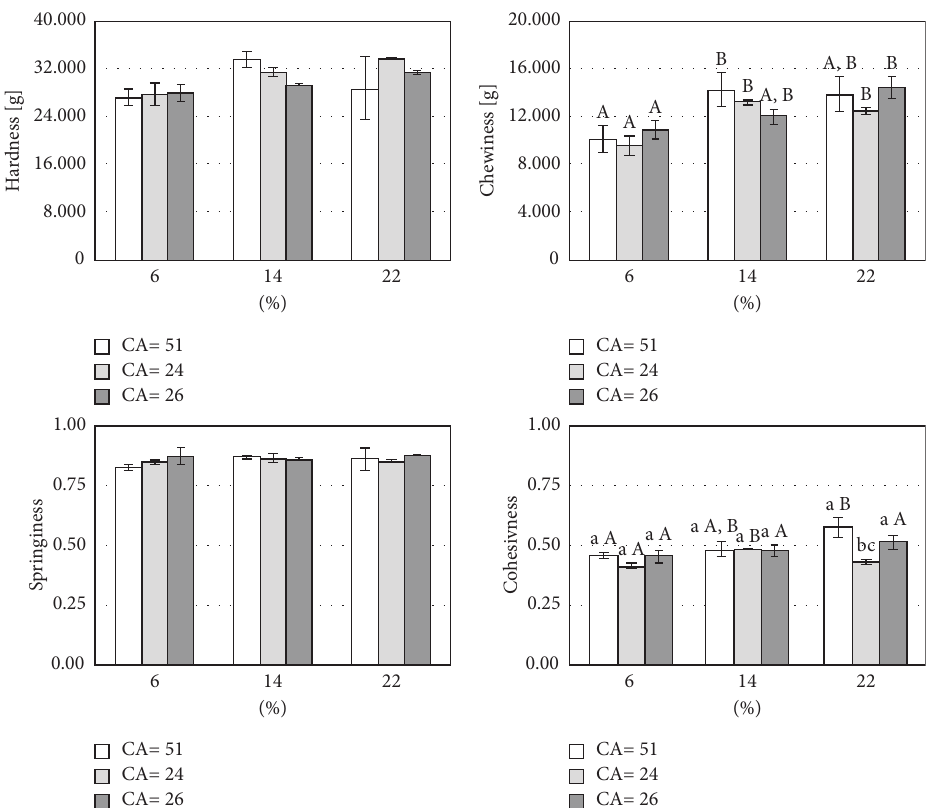
Figure 6: Texture profle analysis parameters for recipe R 1 ( X -axes: overstufng percentage). Means between each same split-plot pa- rameters combination ± standard error. Diferent lowercase letters indicate that the average values difer signifcantly ( P < 0 . 05) by CA (contact angle). Diferent uppercase letters indicate that the average values difer signifcantly ( P < 0 . 05) by